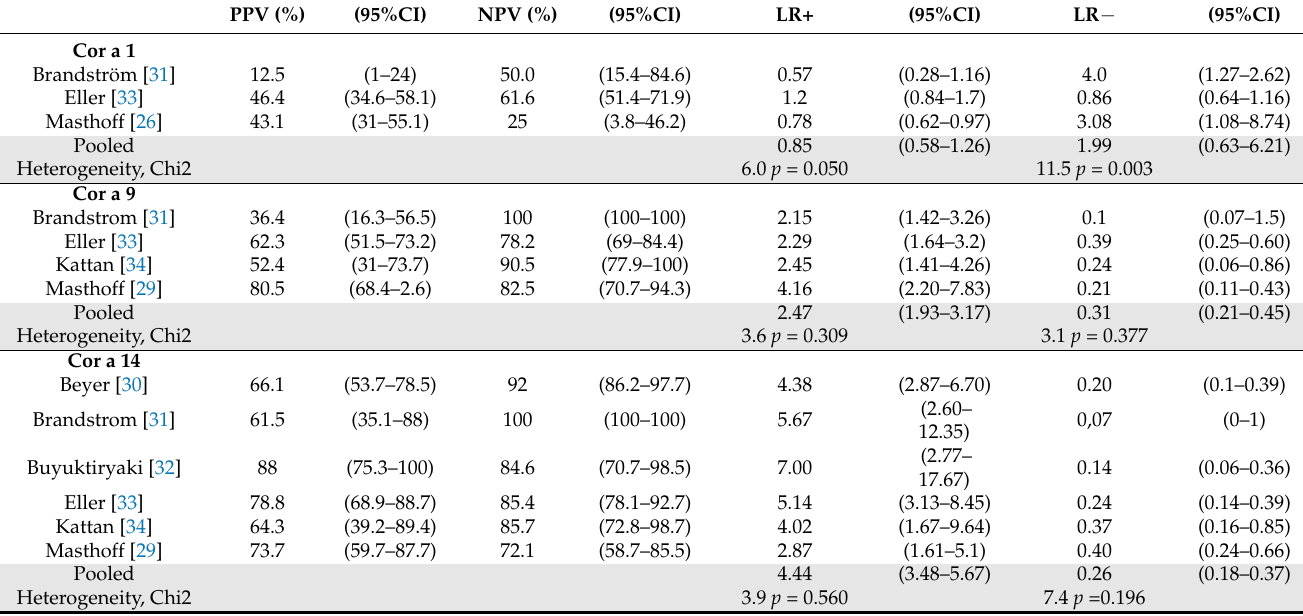
Table 4. Positive predictive value (PPV), negative predictive value (NPV), likelihood ratio (LR) of IgE to Cor a1, Cor a9, Cor